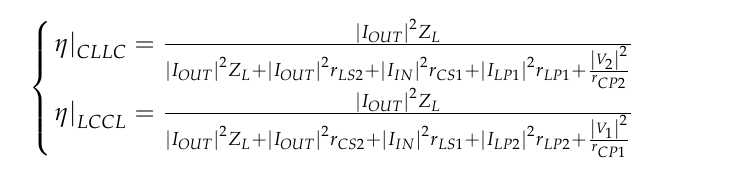
Table 4. Circuit Models Of Capacitor And Inductor With Parasitic Resistance.